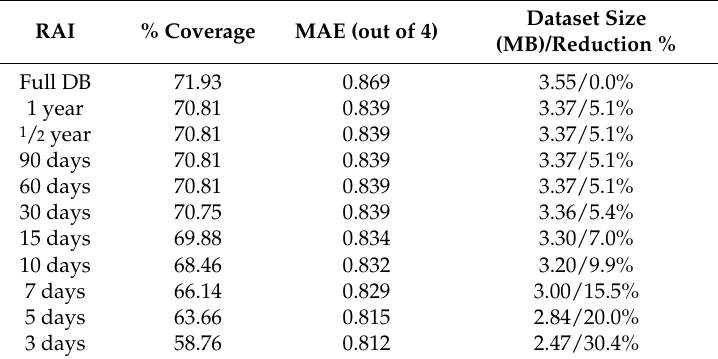
Table 4. Amazon “Videogames” dataset results.